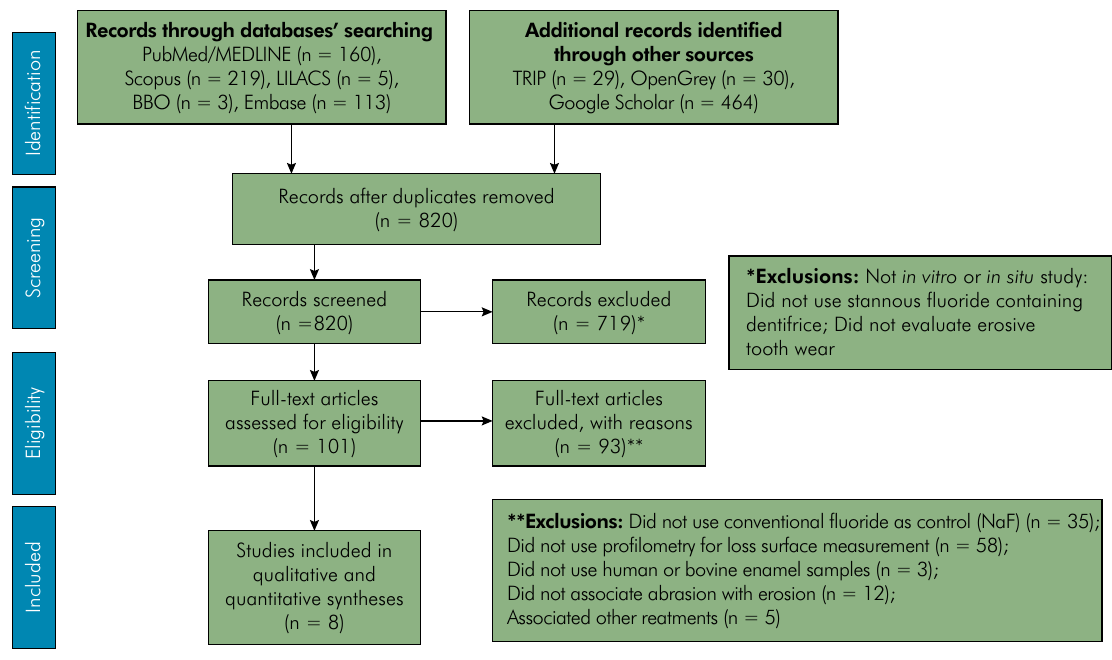
Figure 1. Flowchart diagram of study selection according to PRISMA